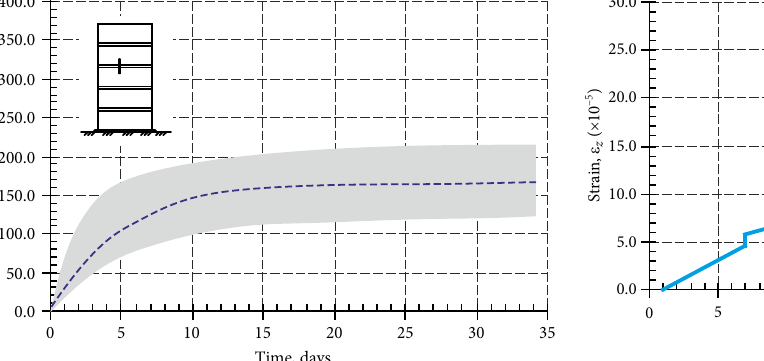
Fig. 10. The dependence of the relative longitudinal deformations of masonry fragment compressed with the changing load over the time